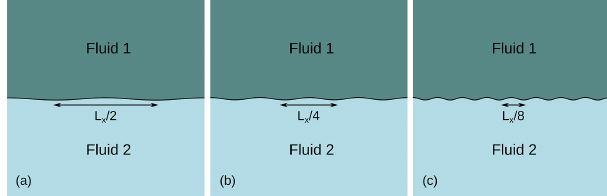
Figure A2. Initial setup of the Rayleigh–Taylor instability bench- mark with three different wavelengths: (a) λ = L x / 2, (b) λ = L x / 4 and (c) λ = L x / 8.